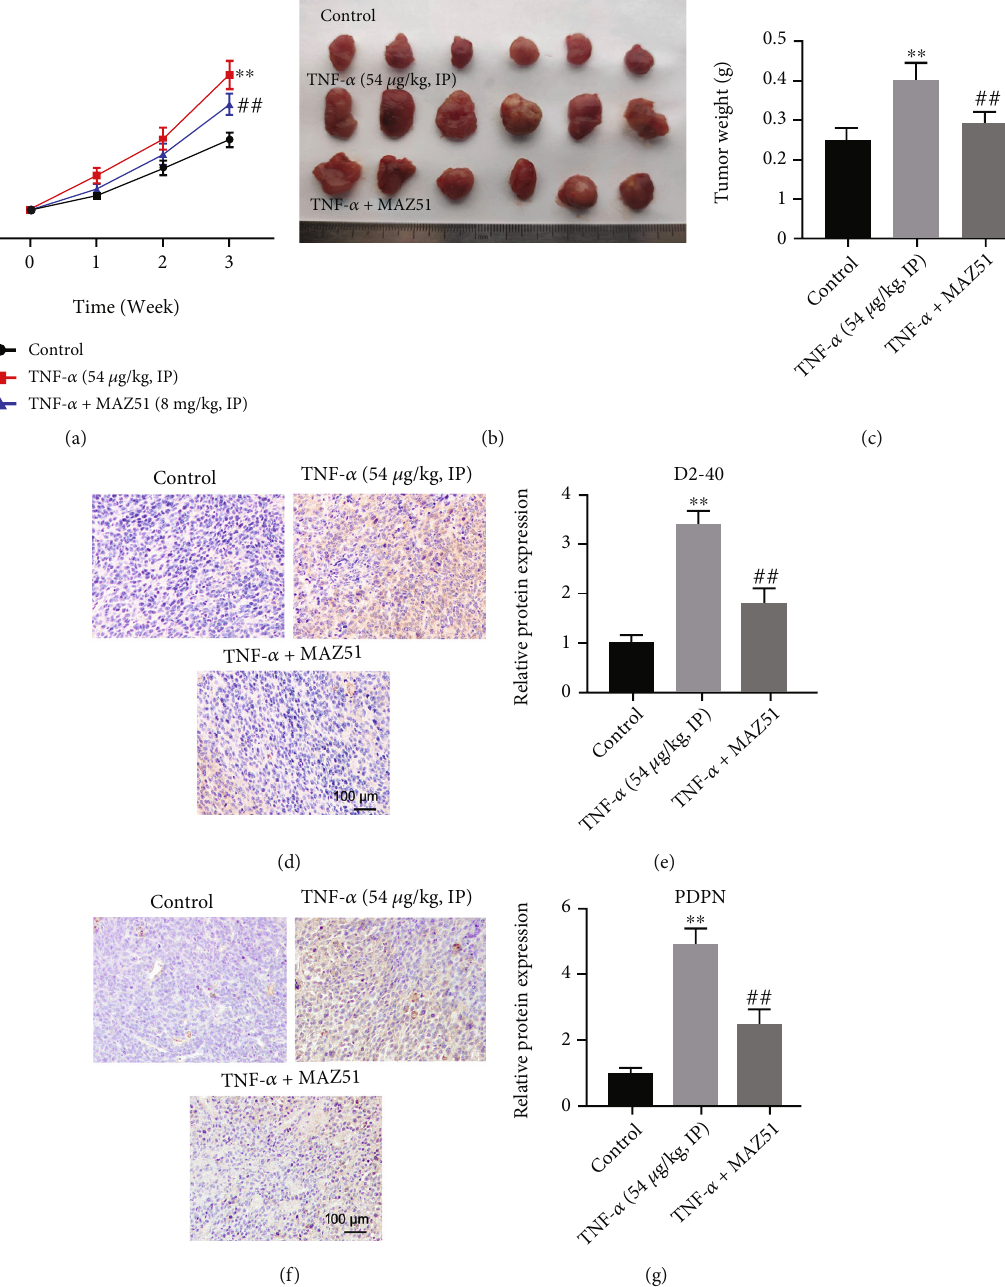
Figure 5: TNF- α promotes the tumorigenesis of cervical cancer in vivo . (a) The tumor volume was measured weekly. (b, c) The tumors were photographed and weighted. (d – g) The level of D2-40 or PDPN in tumor tissue was measured by IHC staining assay. ∗∗ P < 0 : 01 compared with control group; ## P < 0 : 01 compared with TNF- α treated group, n = 3